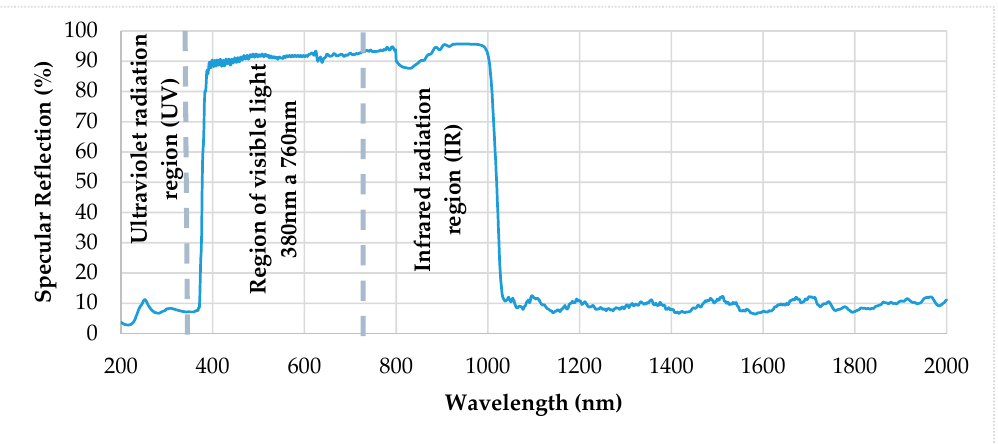
Figure 2. Reflection tests (Reference).